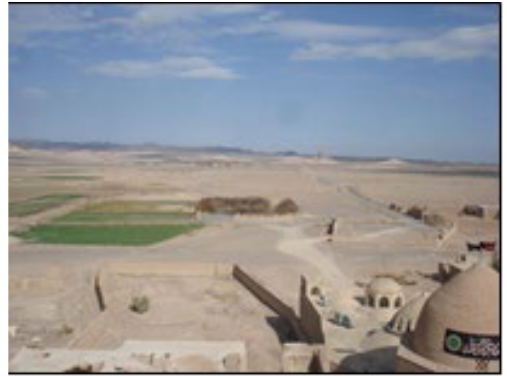
Fig 9: Part of the land that was previously cultivated Fig. 10: Formation of climate-compatible architecture for more compatibility with the hot and dry climate of the region